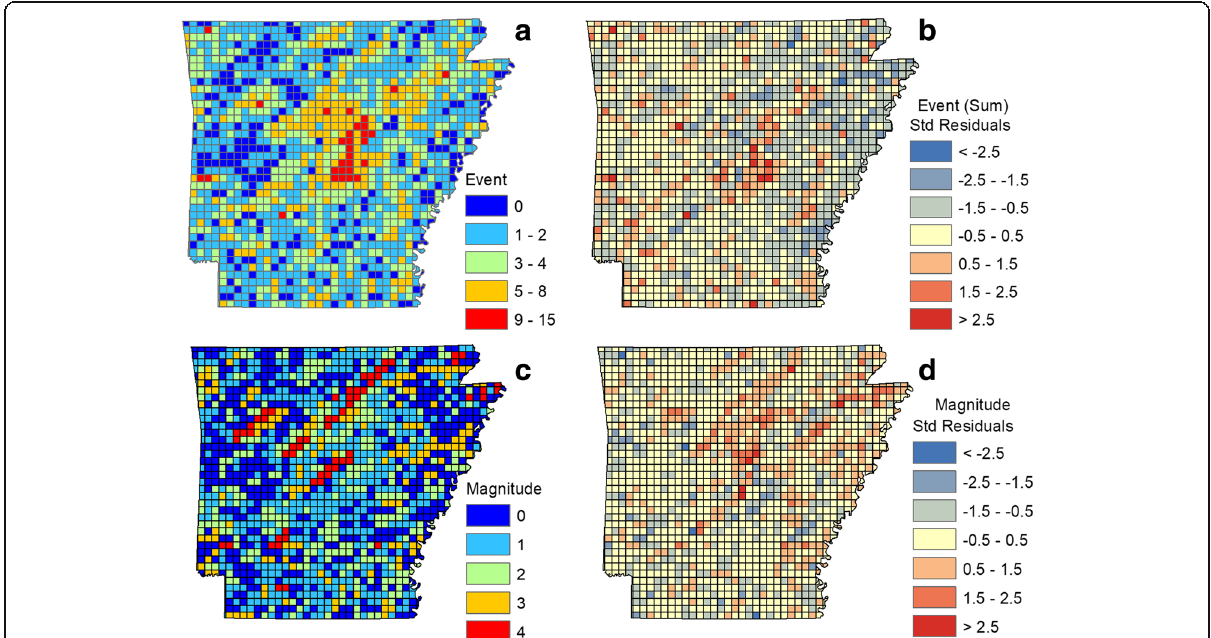
Fig. 7 Ordinary Least Squares (OLS) regression analysis for the explanatory variables influencing tornados (grid cell = 10 × 10 km): a frequency b OLS are dominant within 1 standard deviation (Std) for the explanatory variable residuals c magnitude d OLS show low (< 1) standard deviation for residuals signifying robustness of model